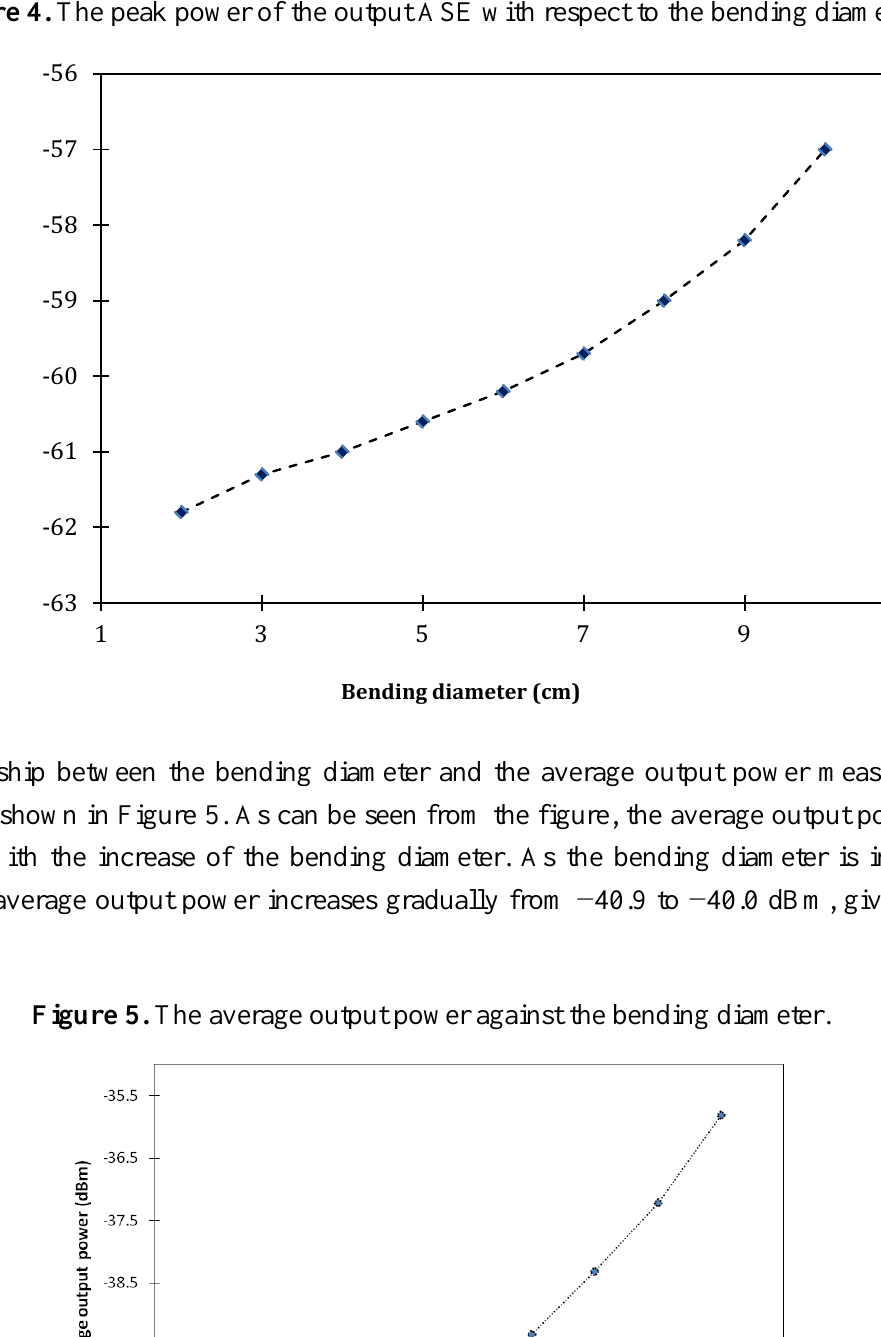
Figure 4. The peak power of the output ASE with respect to the bending diameter.